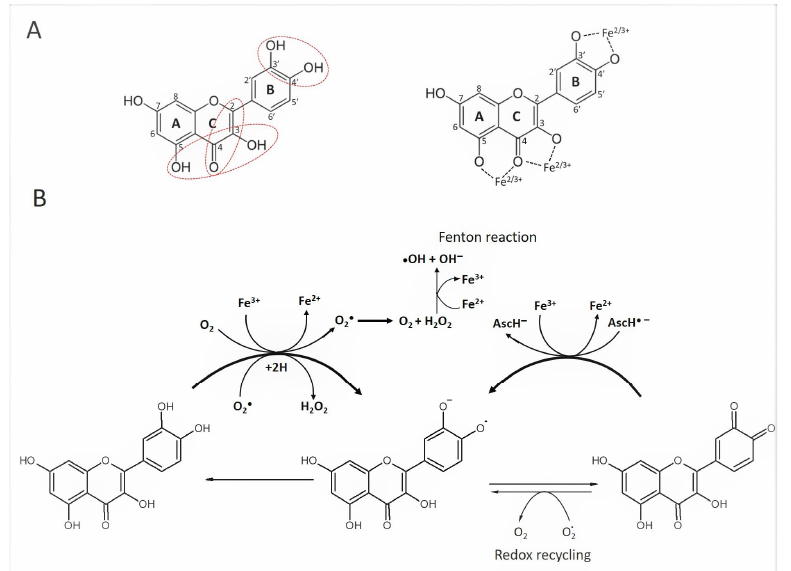
Figure 2. The potential mechanism of non-enzymatic H 2 O 2 production in honey by flavonoid auto- oxidation. ( A ) Structural elements required for an efficient radical scavenging activity and metal ion-chelation are circled [58,60]. Three possible binding sites of a metal cation to a flavonoid. ( B ) A schematic proposal of H 2 O 2 production in honey via flavonoid (quercetin) autooxidation based on literature data (detailed description in the text). Redox cycling and pro-oxidant activity of flavonoid is promoted in the presence of ascorbic acid. Ascorbic acid (AscH − ) is oxidized to ascorbate radical anion (Asc • − ) by one-electron transfer to Fe 3+ and its reduction to Fe 2+ . Ascorbate radical (Asc • − ) reduces quinone to semiquinone radicals propagating redox cycling.